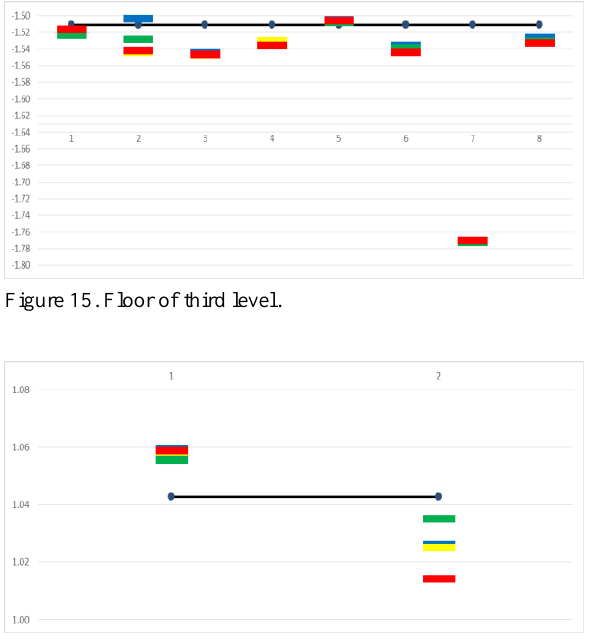
Figure 16. Ceiling of third level.